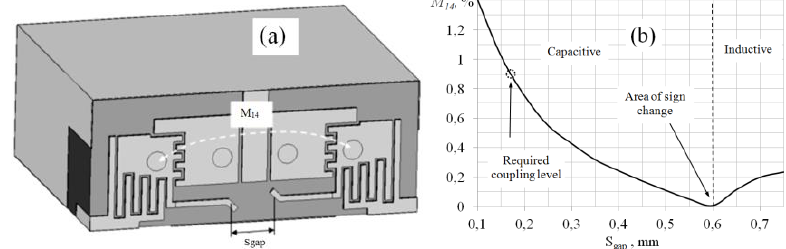
Fig. 8. HFSS 3D electromagnetic model of proposed QEF on MCB (a), dependence of the cross coupling coefficient on the distance between capacitive stubs (b).